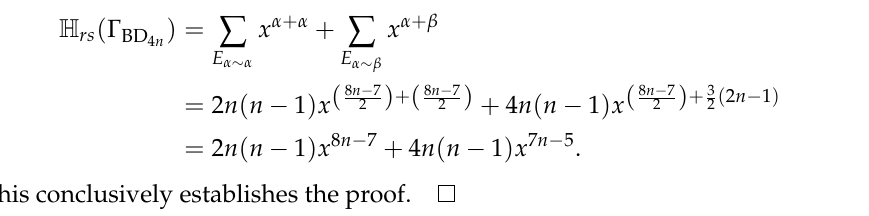
) . Table 4. Edge partition of Γ BD for any x ∼ y ∈ E ( Γ BD 4 n 4 n Kind of Edge Partition of the Edge Set Counting